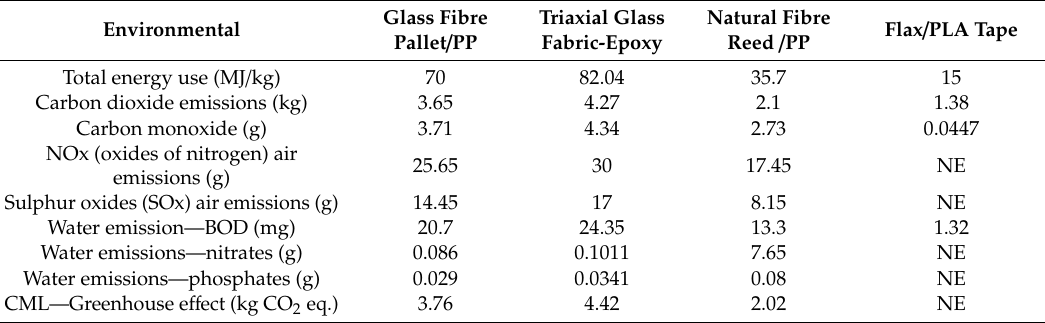
Table 2. Environment impact to produce flax tape compare to glass fibre [42].